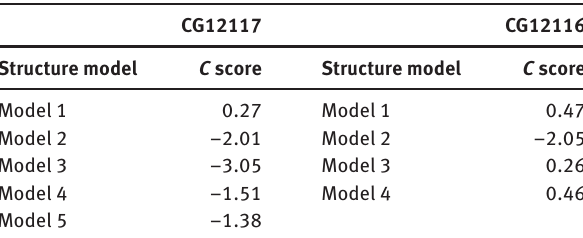
Table 1: C scores of the Drosophila SR models predicted by the I-TASSER